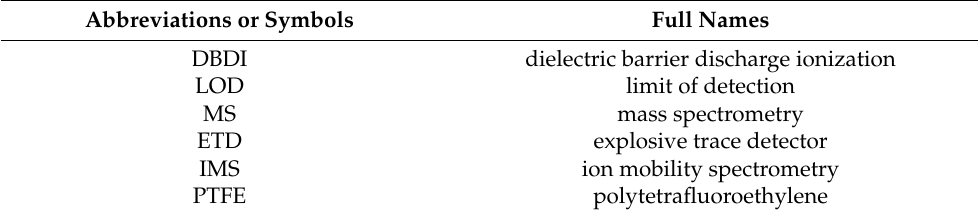
Table 1. The full names of the abbreviations or symbols in this